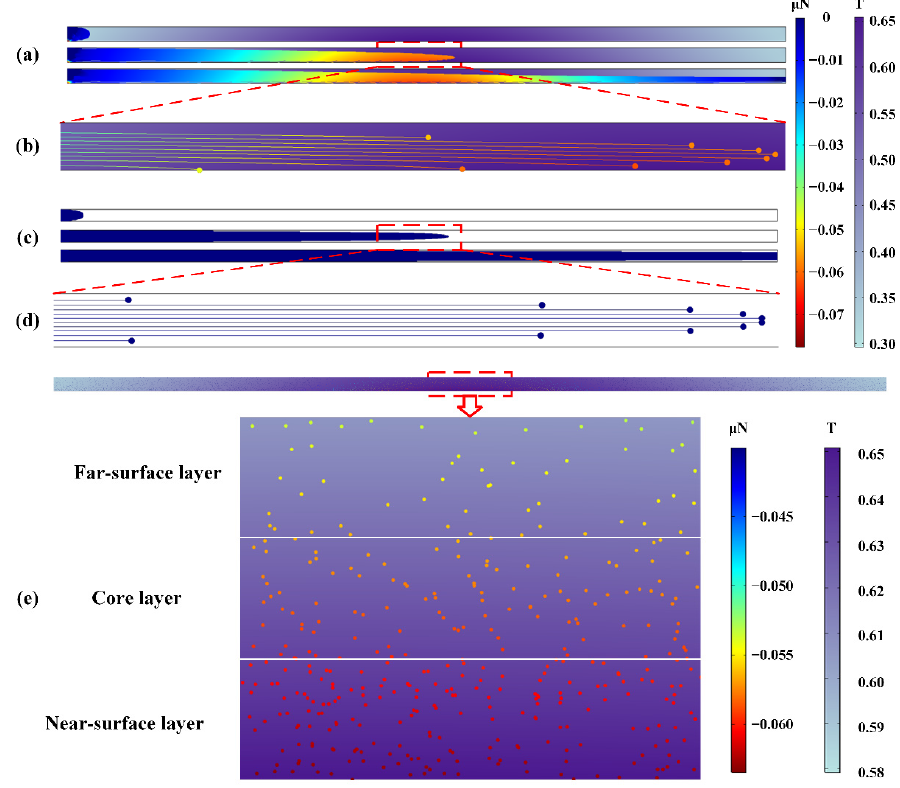
Figure 5. ( a − d ) refers to occurrences in micro mold cavity. Contrast diagrams of ( a , c ) injection mold- ing process, ( b , d ) particle migration with external magnetic field and without magnetic field, and ( e ) particles final distribution.